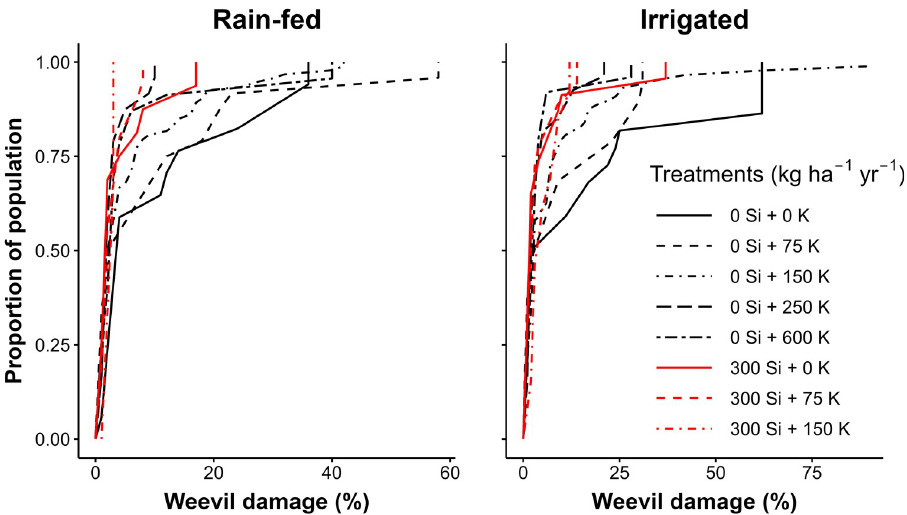
Fig 2. The cumulative distribution function of weevil damage in EAHBs under different water and nutrient treatments. All treatments were sprayed with chlorpyrifos.